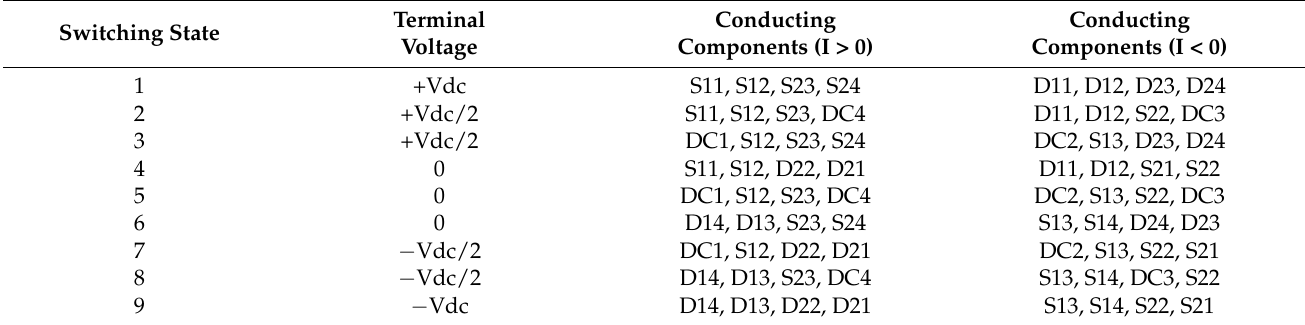
Table 2. Conducting components corresponding to each switching state for positive and negative output currents in healthy